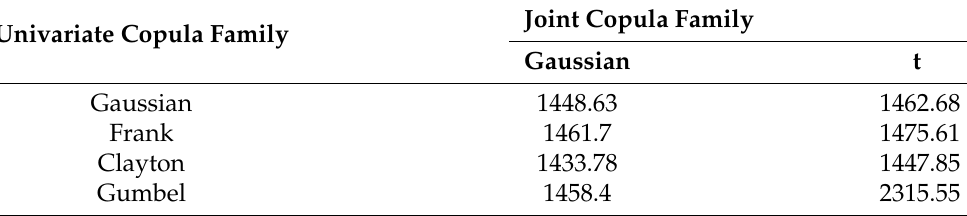
Table 5. AIC values for the bivariate Poisson model with different copula families.